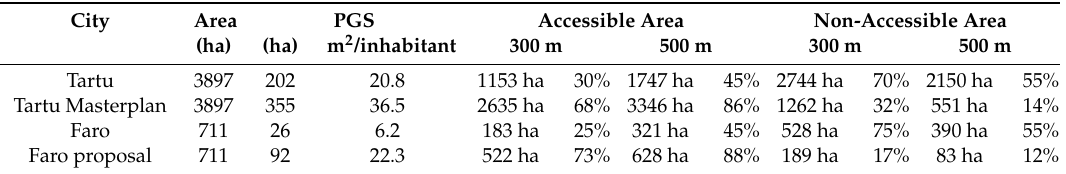
Table 6. Comparison between the current accessibility to the public green spaces (PGS) and after implementing Tartu Masterplan and Faro new green infrastructure proposal.